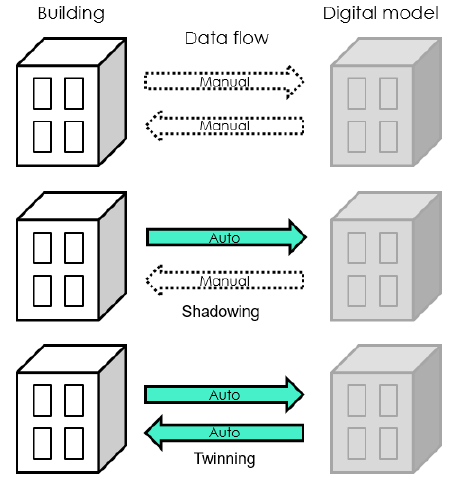
Figure 1. Existence and direction of automatic data flow between the building and its digital representation defines if it is a simple digital model, a shadow of the building, or a digital twin Wagg et al. (2020) highlight the need for contextualisation